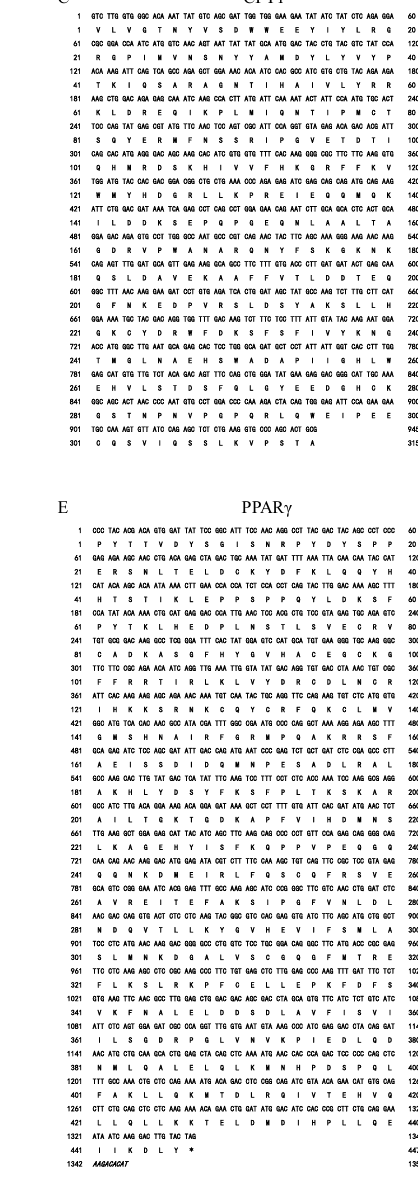
Figure 6. cDNA sequences and deduced amino acid sequences of ( A ) ACC1 , ( B ) FAS , ( C ) CPT1 , ( D ) SREBP , and ( E ) PPAR γ in the Yangtze sturgeons. The asterisk (*) indicates the stop codon.